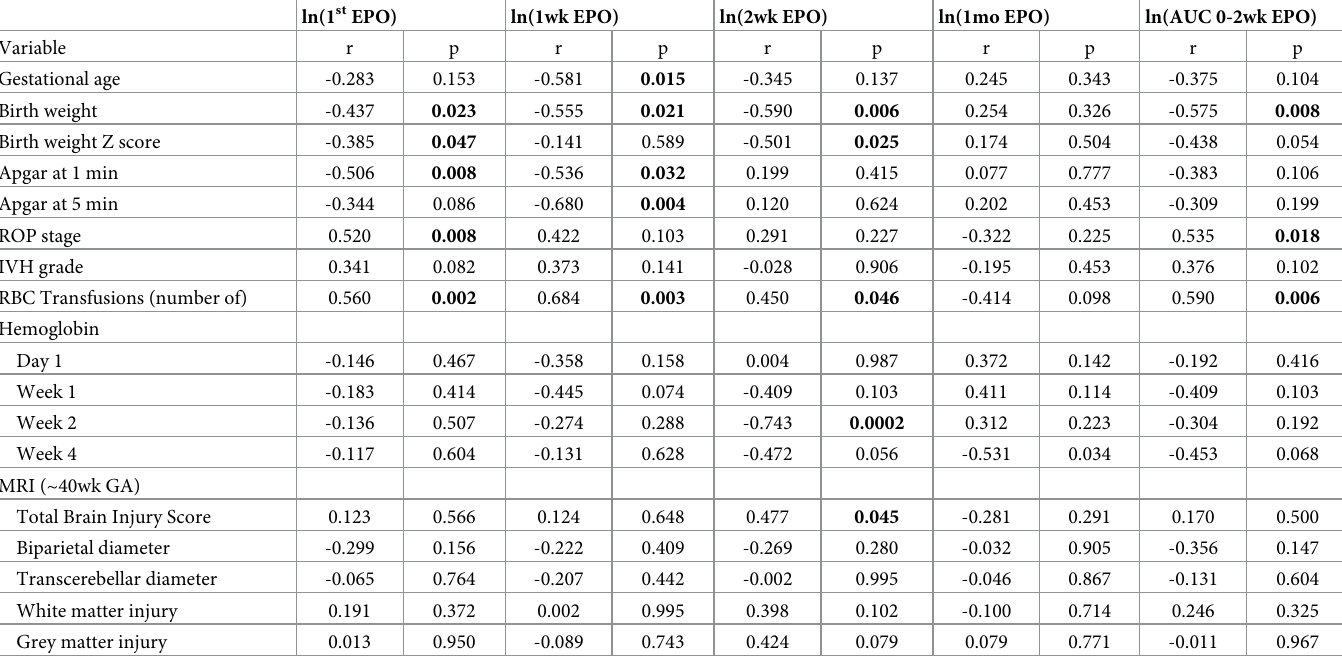
Table 3. Spearman correlation of ln[EPO] with risk factors and